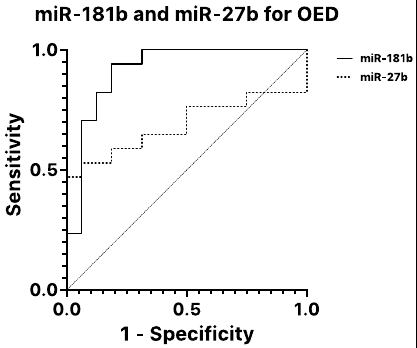
Figure 2. Receiver operating characteristic curve (ROC) and area under the curve (AUC). ROCanalysis of miR-181b (straight line) and miR-27b (dotted line) for discriminating OED from OPMD without dysplasia (ND and control groups). MiR-181b has very good diagnostic values in terms of sensitivity and specificity (AUC = 0.9154; standard error = 0.05315; 95% C.I. = 0.8113 to 1); miR-27b, on the other hand, is below the acceptable threshold (AUC = 0.6875; standard error = 0.09916; 95% C.I. = 0.4931 to 0.8819). The reference line is represented with a dashed